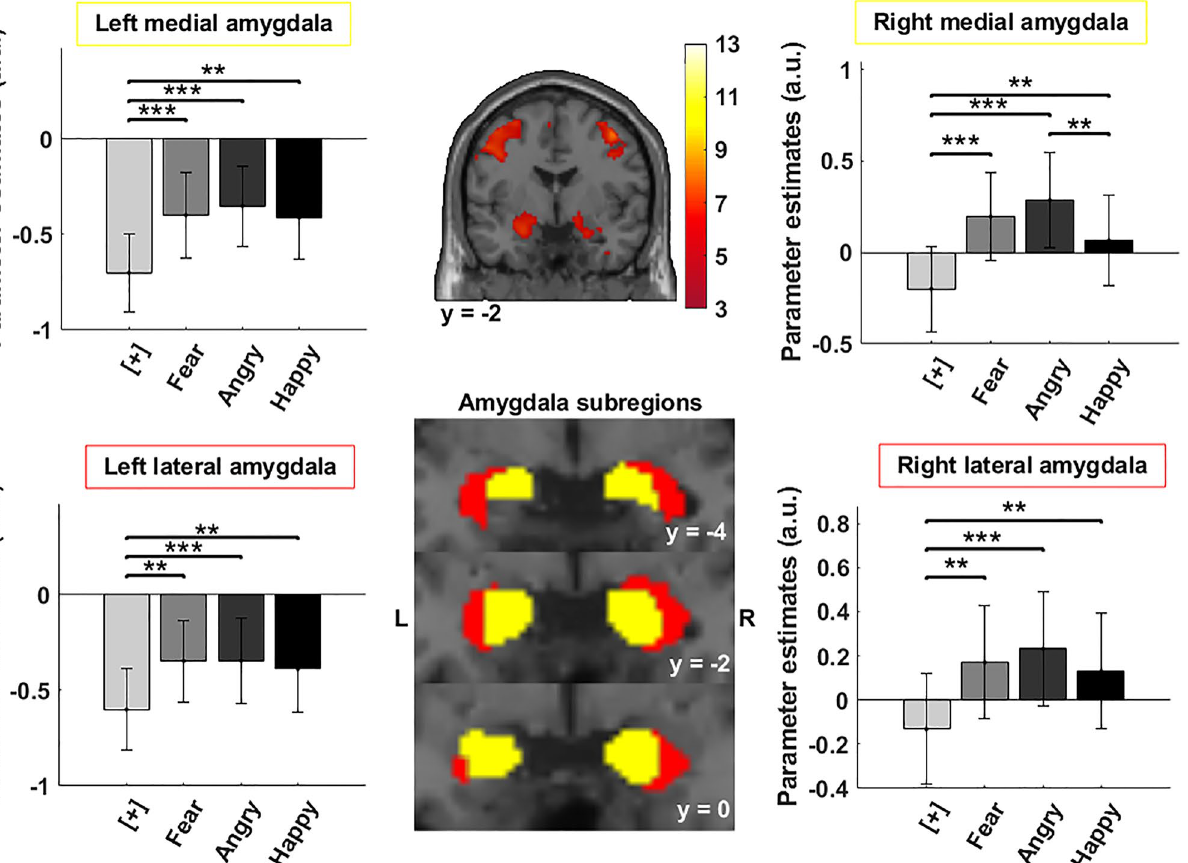
Figure 2. Amygdala subregional BOLD signal in response to emotional faces or fixation cross. Repeated measure ANOVAs were conducted to compare the sub-regional activation in the four conditions (fixation cross, Fear Face, Angry Face, and Happy Face), except for the right medial and the left lateral amygdala for which a Friedman test was conducted. These analyses showed that in all sub-nuclei, emotional faces significantly increased the BOLD signal compared to fixation (*p < 0.05, **p < 0.01 and ***p < 0.005; Bar graphs represent mean bold signal and error bars represent